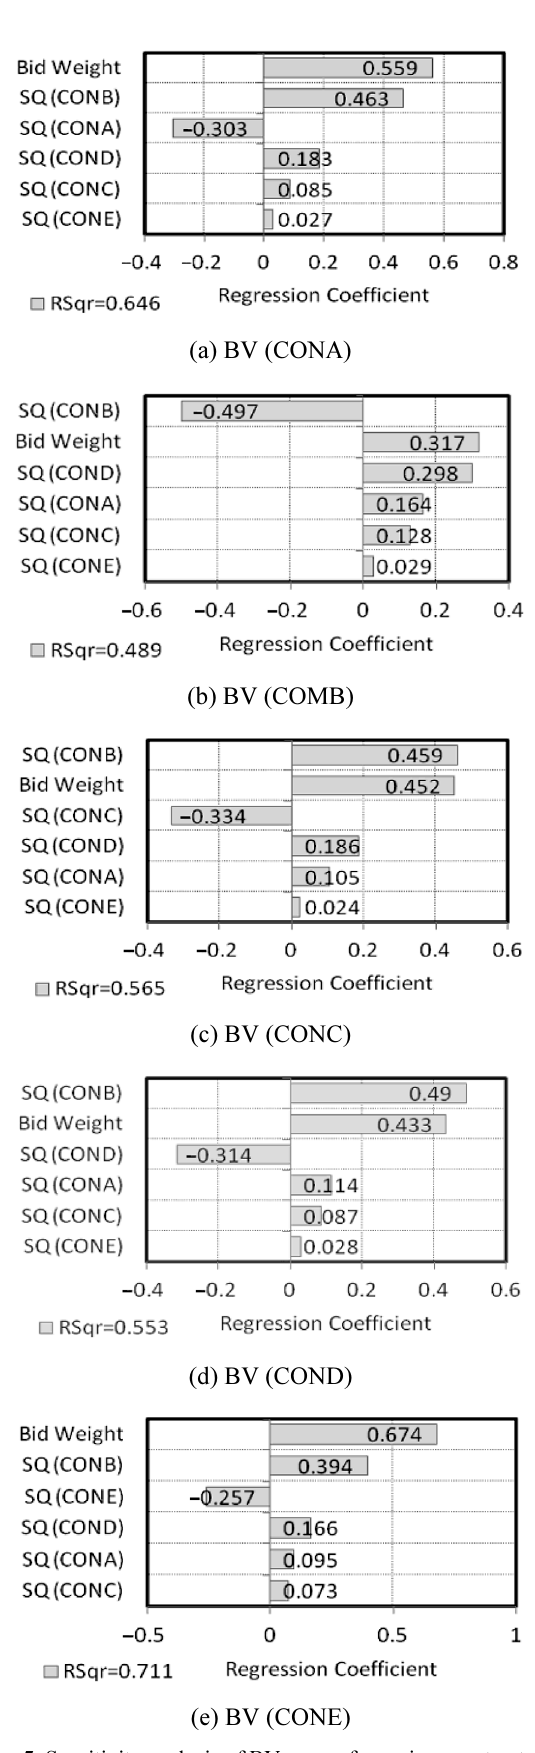
Fig. 5. Sensitivity analysis of BV scores for various